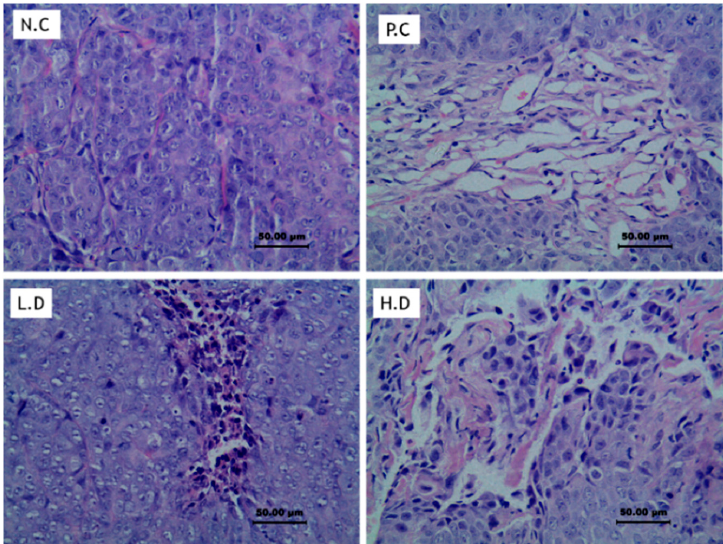
Figure 3. Histology sections of control and CADMN-treated nude mice. The sections of untreated group (NC) showed large solid tumor tissues, sections treated mice (H.D and P.C) showed larger area of tumor necrotic characterized by cell shrinkage, fragmentation, and chromatin disappearance with a small island of tumor tissues. Magnification 40 ×, NC: negative control, PC: positive control (5-FU), LD: low dose (25 mg/kg CADMN), and HD: high dose (50 mg/kg CADMN).